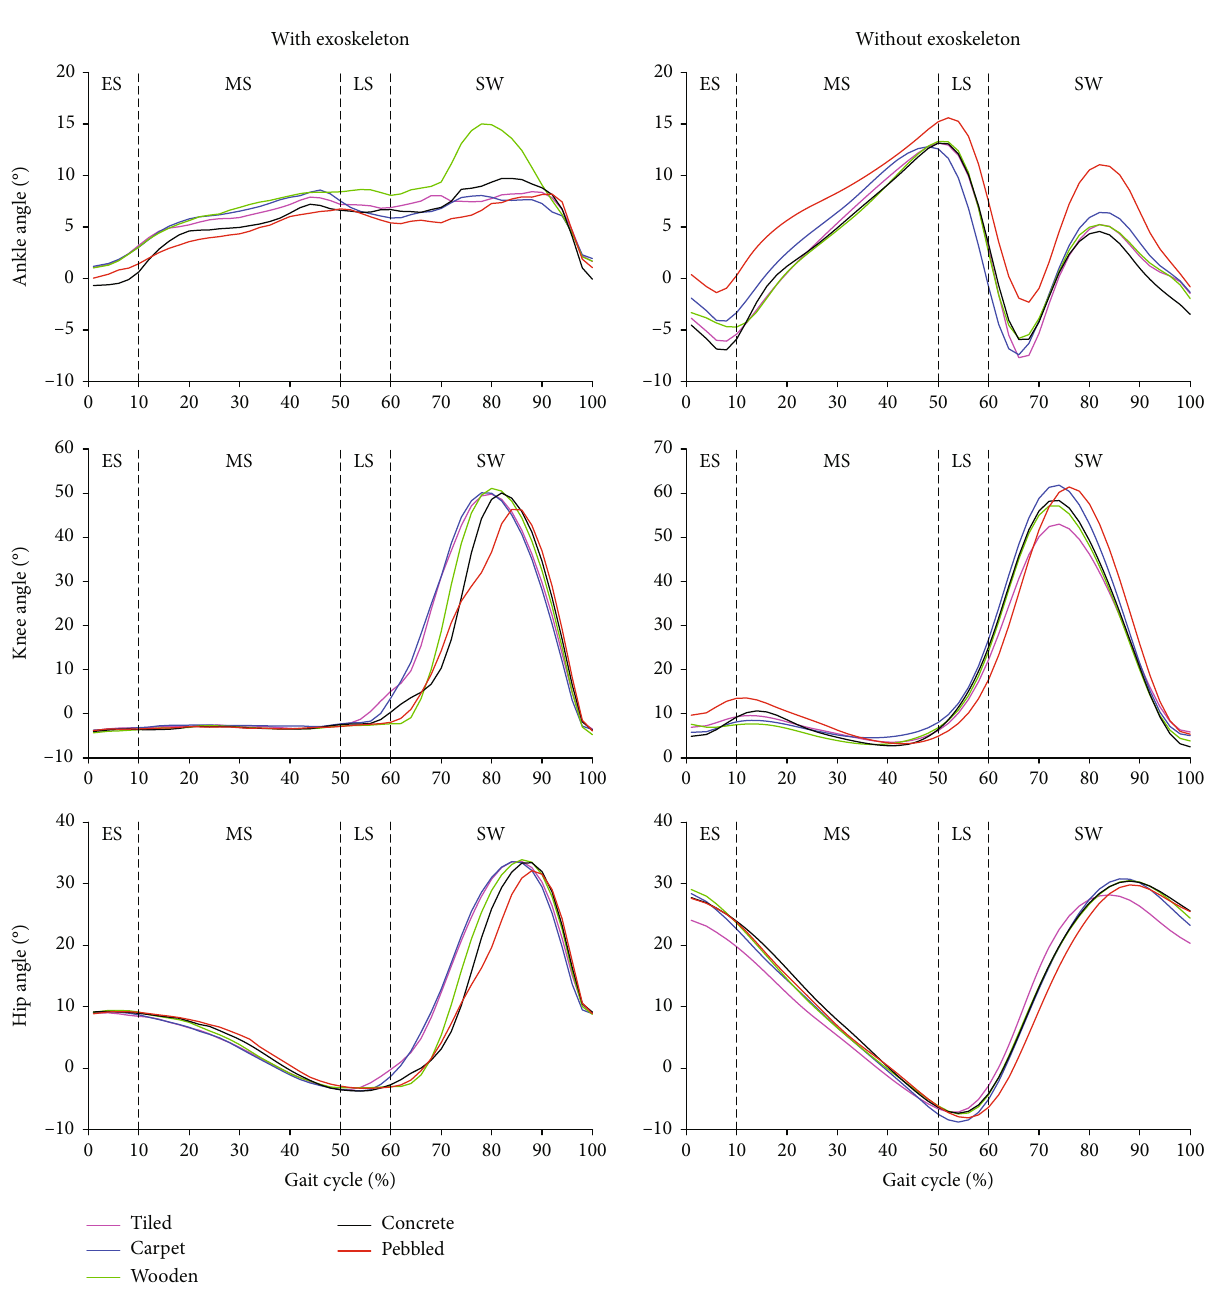
Figure 2: Changes in kinematics at the ankle, knee, and hip. Mean angle of the ankle, knee, and hip in a sagittal plane for participants ( n = 8 ) with/without exoskeleton over the gait cycle on each kind of pavements. The gait cycle is from the heel strike to the next heel strike of the left foot. ES =early stance; MS= midstance; LS =late stance; SW =swing